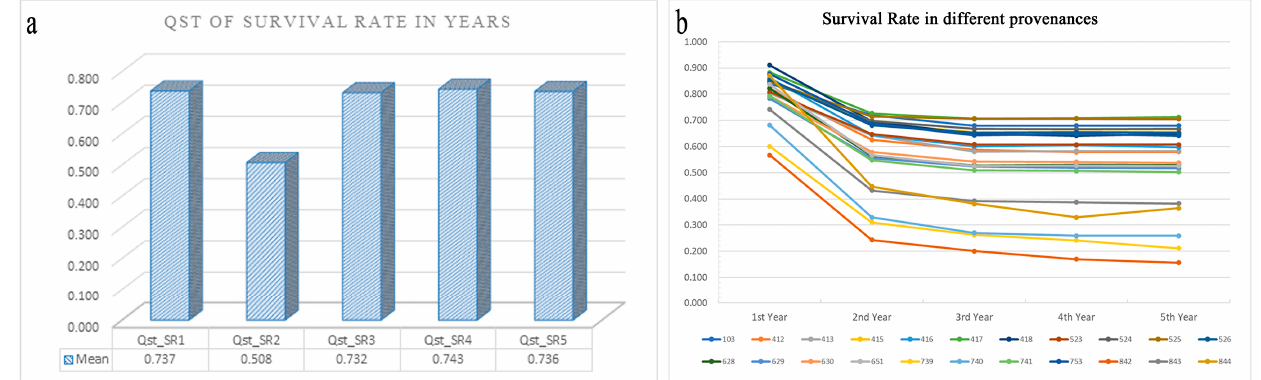
Figure 6. Q ST mean value of the survival rate in each year ( a ); the survival rate of the different provenances in the five years ( b ).